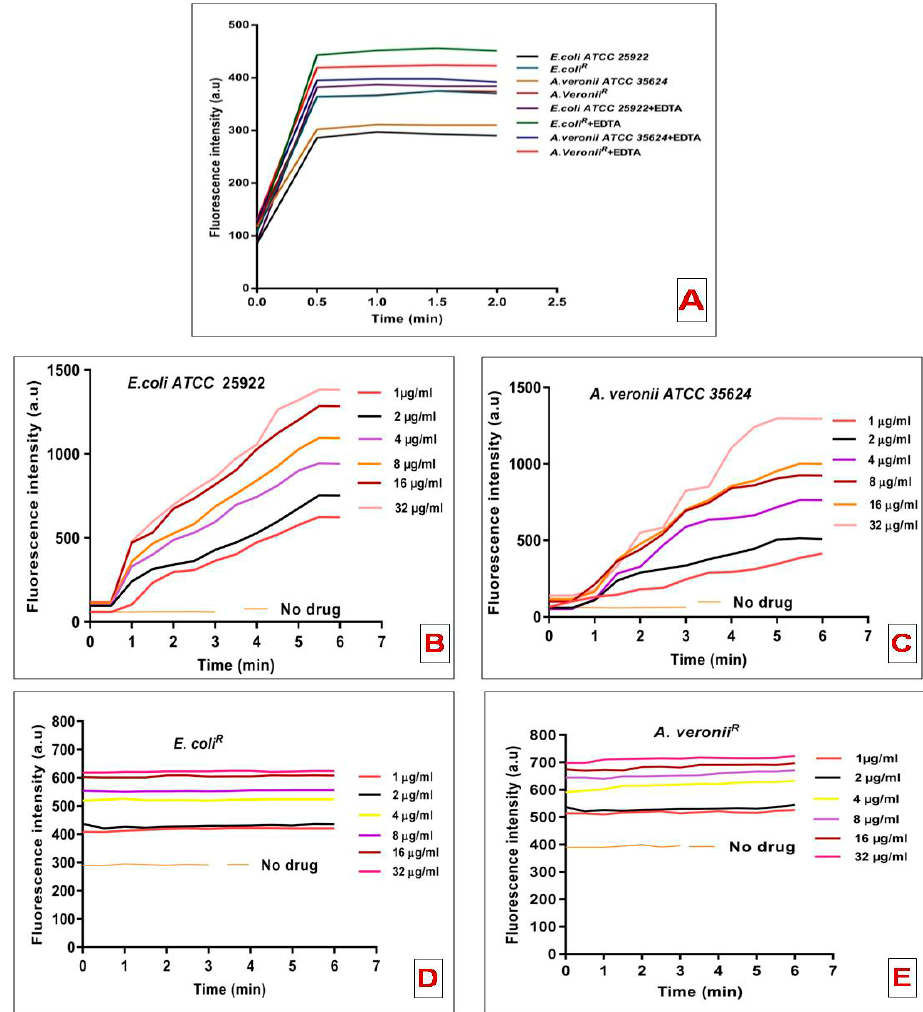
Figure 3. NPN uptake kinetics of mid-logarithmic phase of E. coli and A. veronii cell suspension ( A ); Effect of increasing concentrations of colistin on the uptake of NPN into the outer membrane of E. coli ATCC 25922 ( B ); A. veronii ATCC 35624 ( C ); E. coli R ( D ) and A. veronii R ( E ).